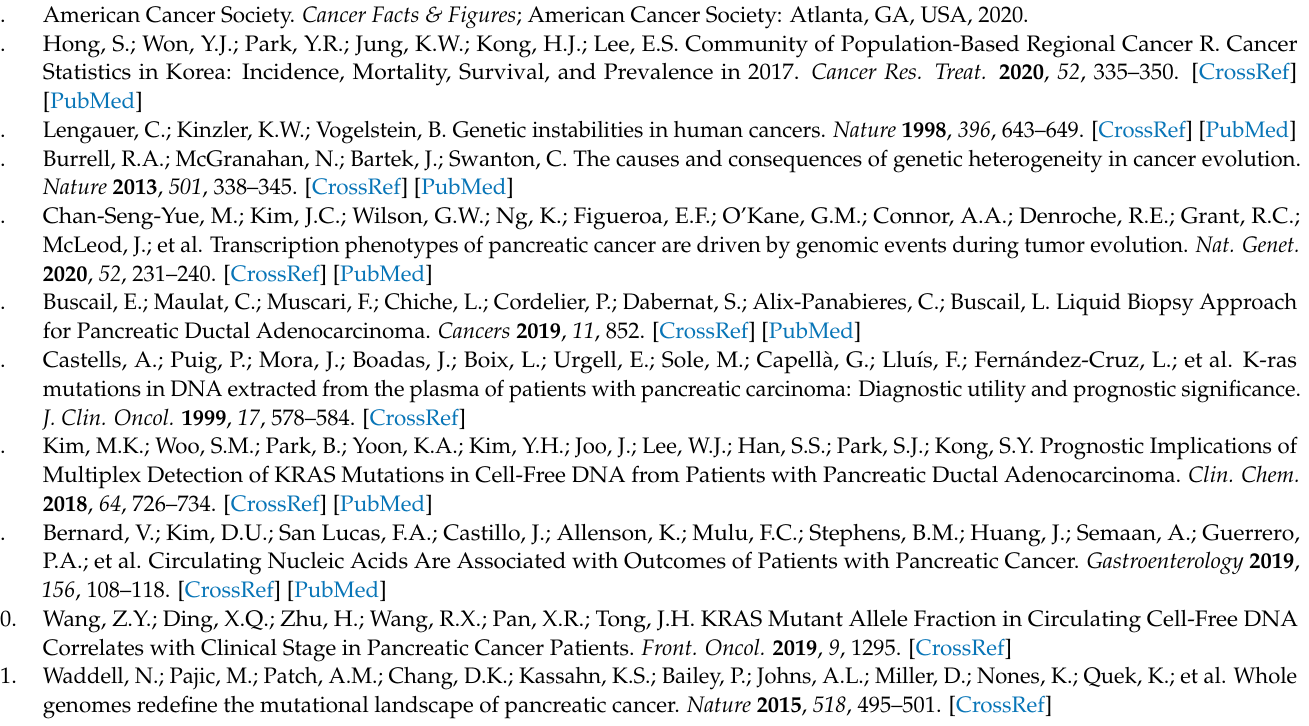
between Chemagen and Qiagen kit in each status, Table S2: Clinico-pathological characteristics between I-score high and low group in each status, Table S3: Objective responses in patients receiving FOLFIRINOX * as first line chemotherapy, Table S4: GISTIC Classified Amplification and Deletion Regions, Table S5: Genes included in GISTIC amplification and deletion regions, Table S6: Top N most significant genes showing prognostic impact on overall survival, Table S7: Overlap profile of the top N most significant genes in each cross-validation